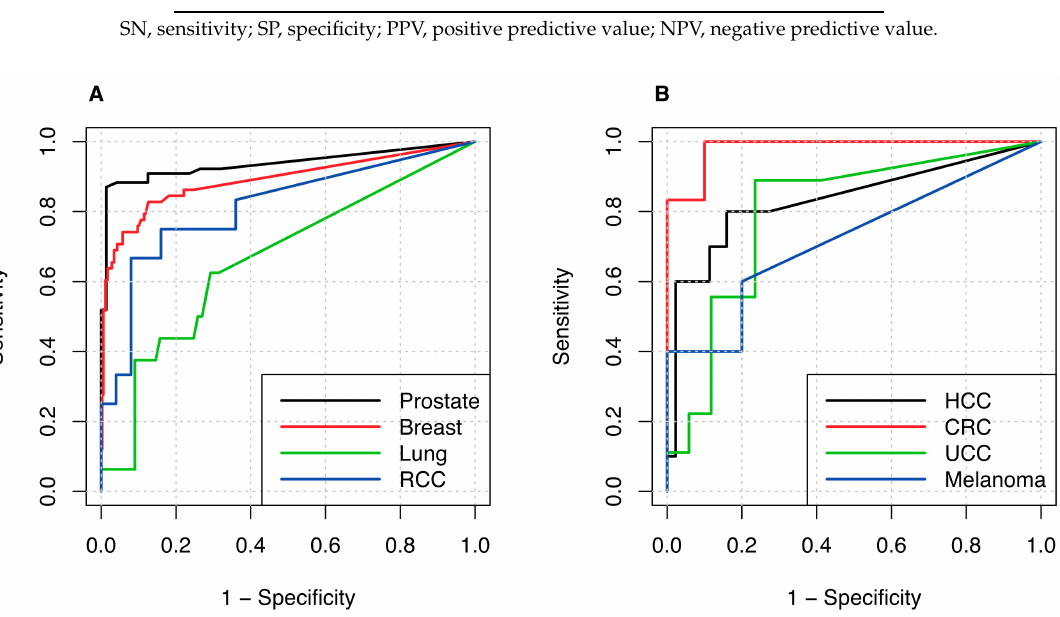
Figure 4. ROC curves: ( A ) tumor entities with osteotropic potential: prostate cancer, breast cancer, lung cancer, and kidney cancer, and ( B ) HCC, CRC, UCC, and melanoma. ROC, receiver operator characteristics; RCC, renal cell carcinoma; HCC, hepatocellular carcinoma; CRC, colorectal cancer; UCC, urothelial cell